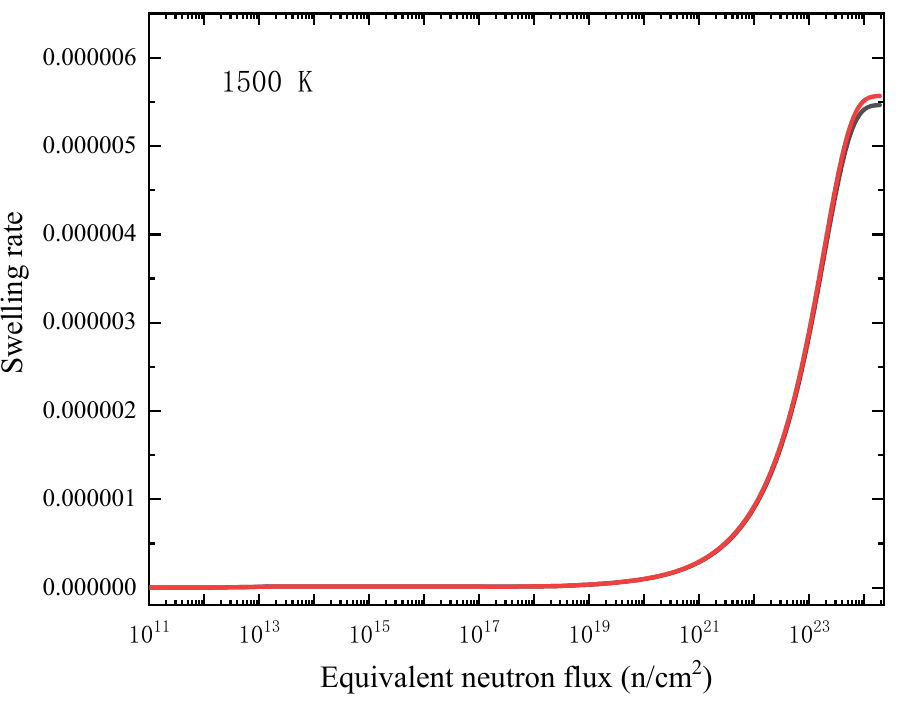
Figure 9. Relationship between swelling rate and equivalent neutron flux (1 MeV) in the central region of SiC film at 1500 K. Black line corresponds the calculations with excess volumes from small-size (10 a × 10 a × 10 a ) supercell simulations and the red line corresponds the calculations with excess volumes from large-size (20 a × 20 a × 20 a ) supercell simulations.